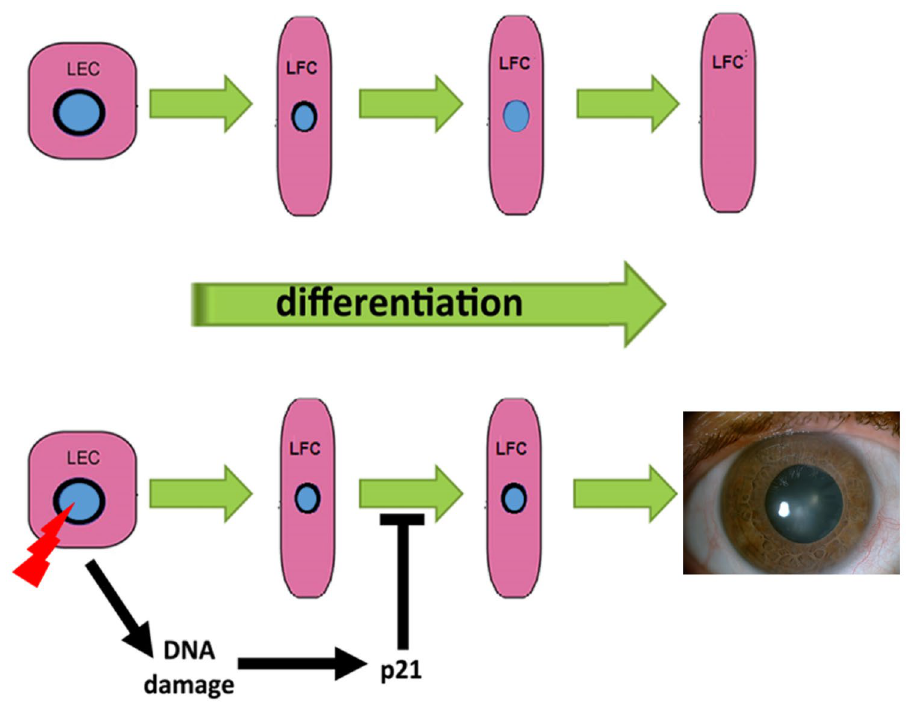
Figure 14. Proposed model of DNA damage-induced cataract. In the upper panel, the normal process of differentiation from LEC to lens fiber cells (LFC) comprises loss of the nuclear envelope (in black) and consequent degradation of the nucleus (in light blue color). In the lower panel, X-ray-induced DNA damage causes an increase of p21, which impedes the disassembly of the nuclear envelope, thus impairing differentiation and leading to cataract